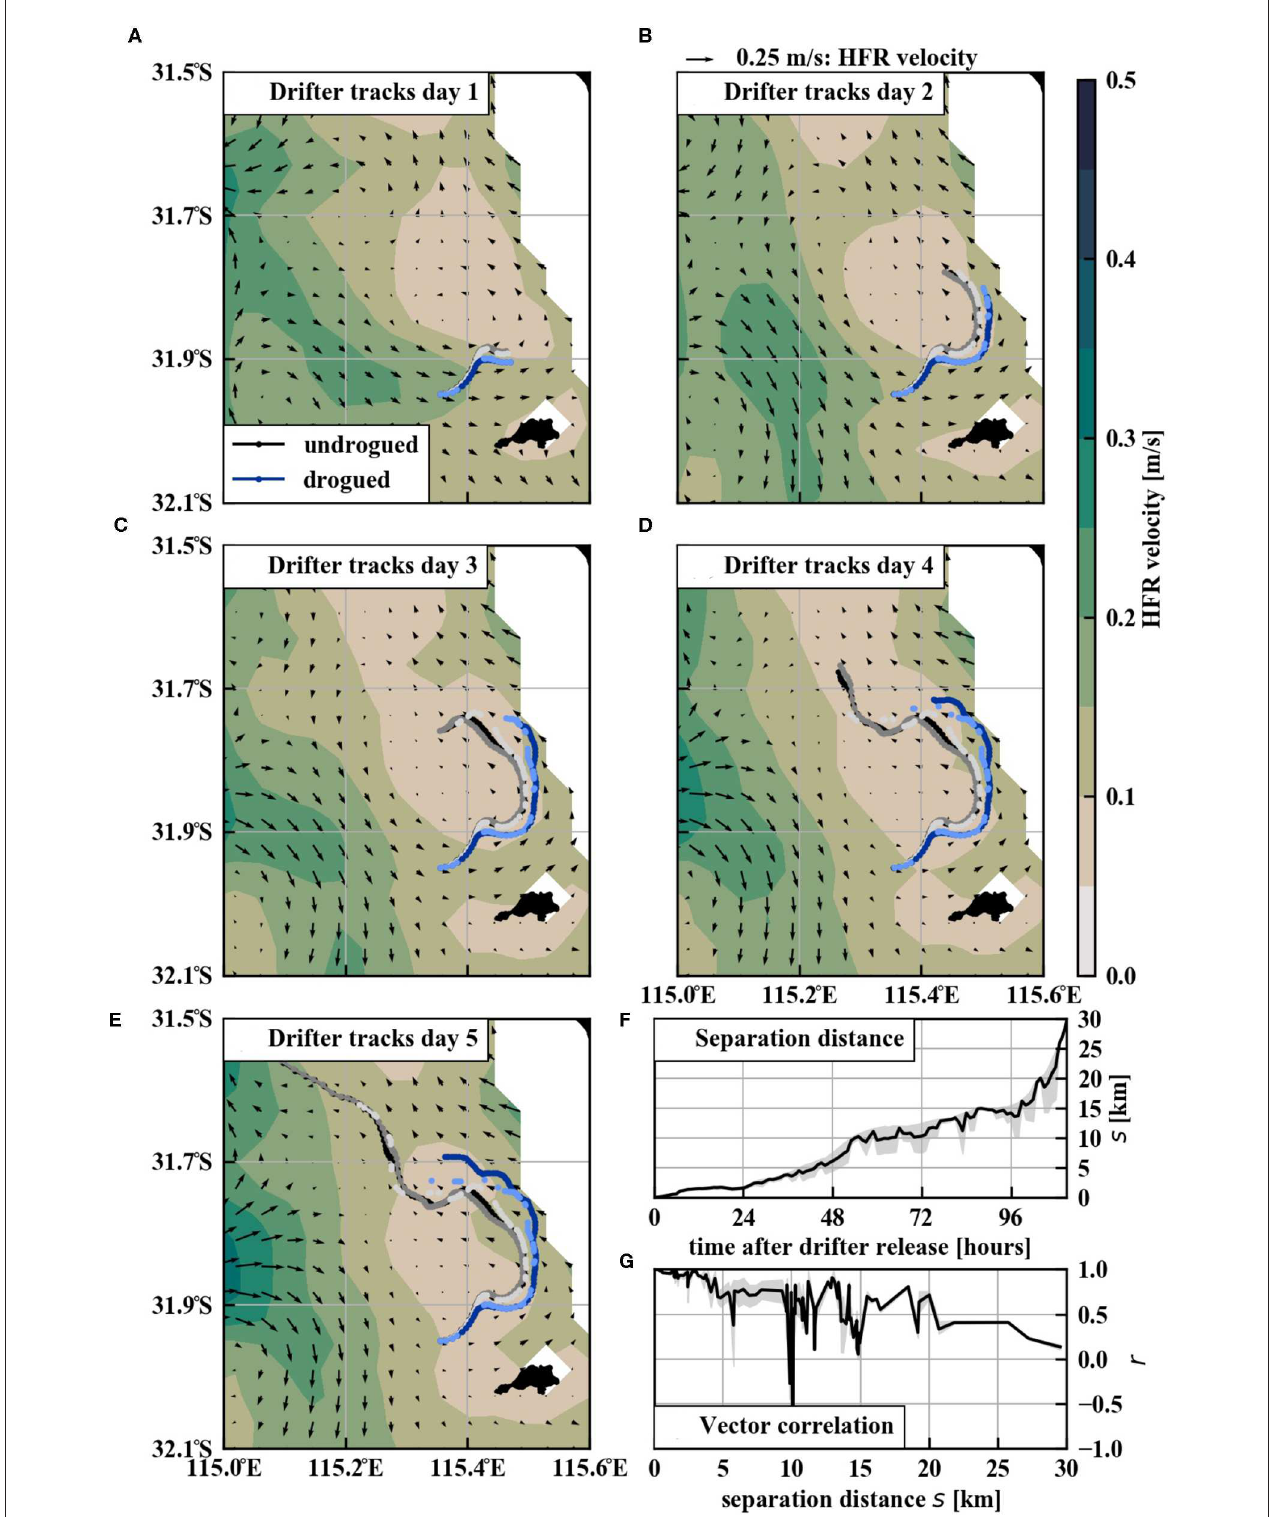
FIGURE 2 | (A–E) Drifter tracks and daily mean HFR measured current field for the first 5 days after drifters release. (F) Mean separation distance s between undrogued and drogued drifters over time. Gray shading shows the minimum and maximum separation distance between an undrogued and drogued drifter. (G) Vector correlation magnitude r between undrogued and drogued drifters as a function of the separation distance. Following Rohrs et al. (2012) a vector correlation of 1 indicates perfect alignment of vectors, whereas − 1 indicates perfect anti-alignment.